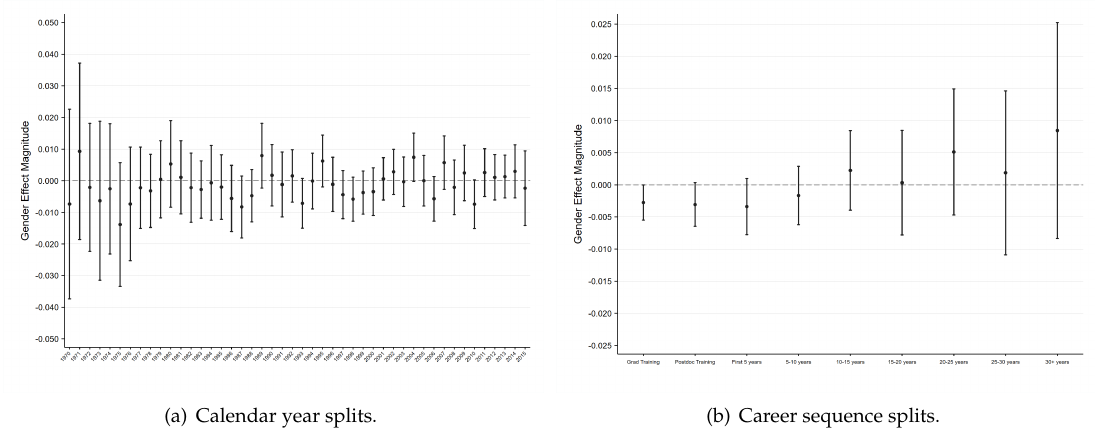
Figure 3: Gender effect magnitudes. Notes : Panel A displays coefficient estimates (and associated 95 percent confidence intervals) for the gender effects in 26 distinct regressions modeled after the specification in Table 4, column 5. Each regression is run on a subsample that only includes source publications that appeared during a specific year, from 1970 to 2015. Panel B proceeds in the same spirit but breaks down the data into nine subsamples corresponding to natural career intervals: graduate school, postdoctoral fellowship(s), first five years post-training, years 5 to 10, ... , years 25 to 20, and finally beyond the 30th year of